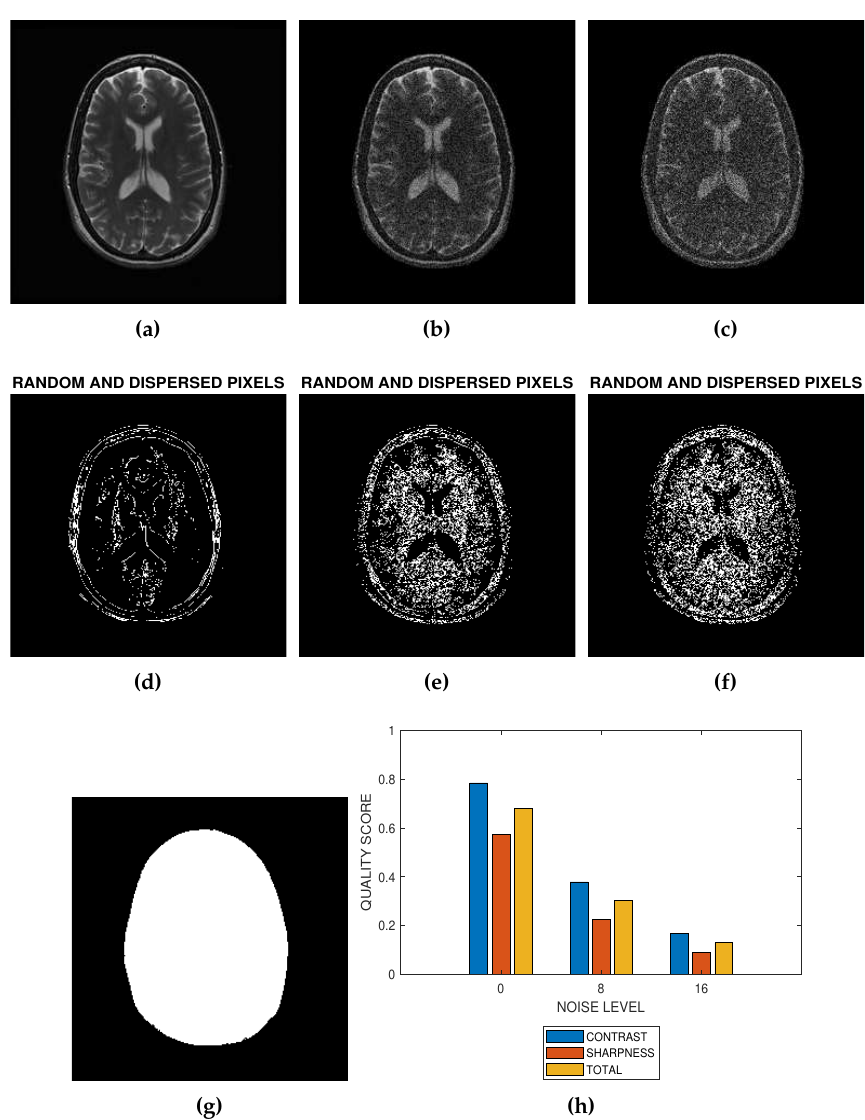
Figure 2. The implementation of blind noise-based quality assessment in MRI images. ( a ) The test image provided by NeuroRx Research Inc. ( b ) Degraded version of the test image in ( a ) at 8 percent Rician noise. ( c ) Degraded version of the test image in ( a ) at 16 percent Rician noise. ( d ) Random and dispersed pixels in the test image in the absence of noise distortion. ( e ) Random and dispersed pixels in the test image at 8 percent Rician noise. ( f ) Random and dispersed pixels in the test image at 16 percent Rician noise. ( g ) The Foreground extracted from the test image in ( a ). ( h ) Variation of contrast, sharpness and total quality scores at Rician noise levels of 0 percent, 8 percent and 16